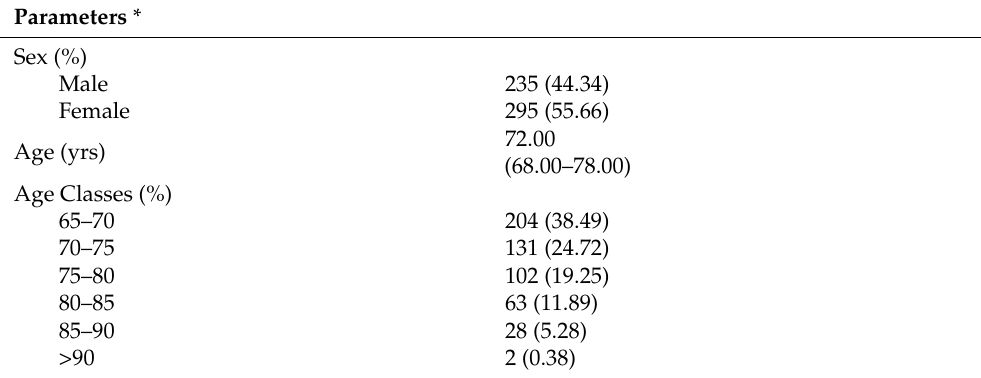
Table 1. Sociodemographic and OCT variables of the sample (n = 530). The Salus in Apulia Study. Parameters